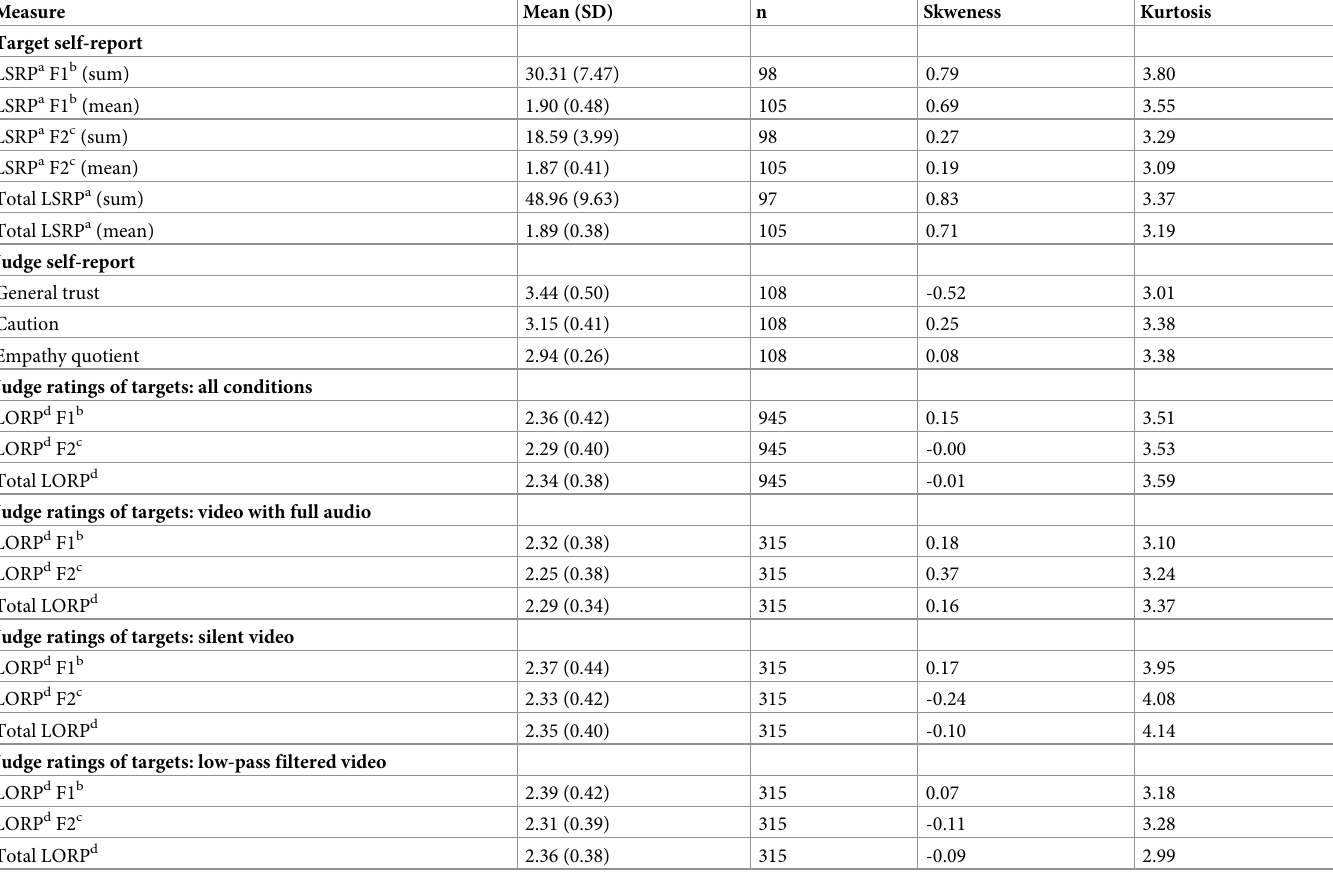
Table 1. Descriptive statistics for target and judge self-report measures and ratings.